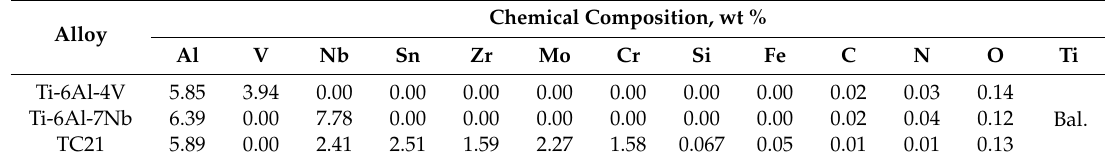
Table 1. Chemical composition of investigated Ti